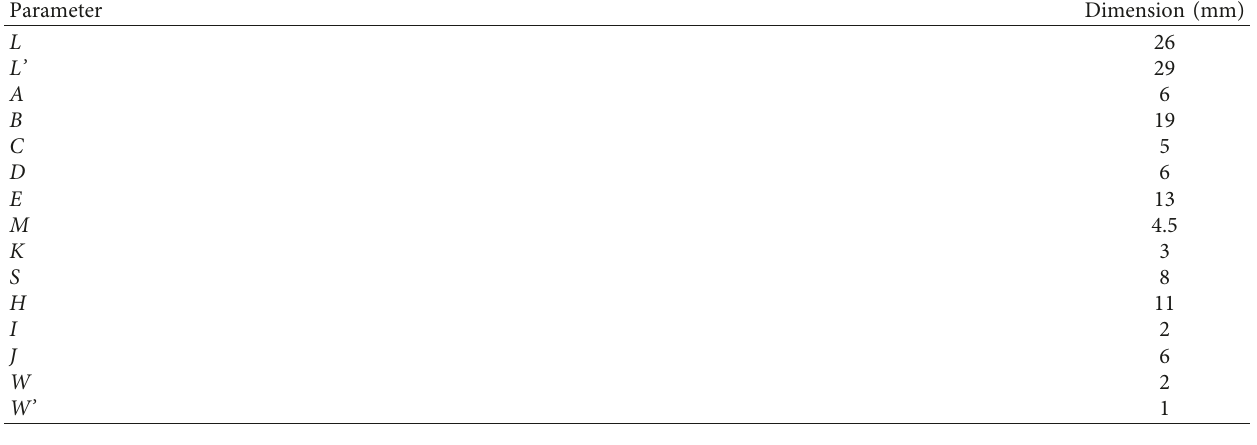
Table 3: Dimensions of the second proposed epidermal antenna.